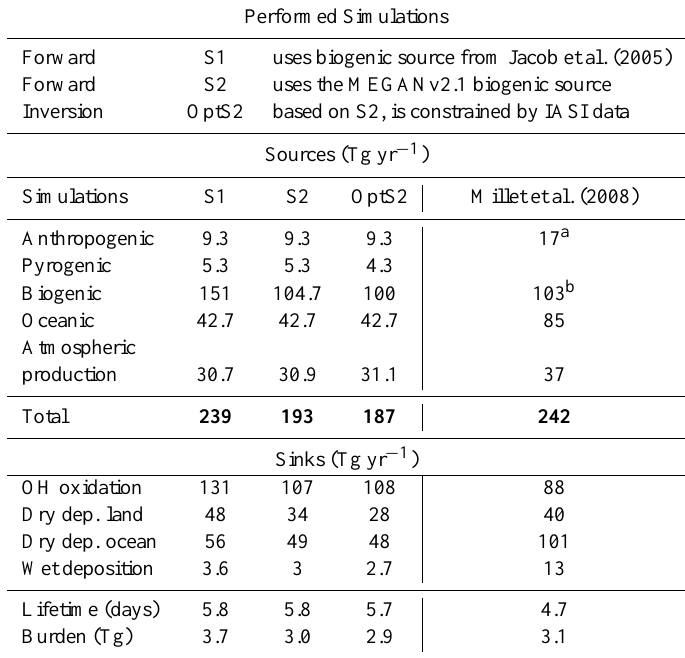
Performed Simulations